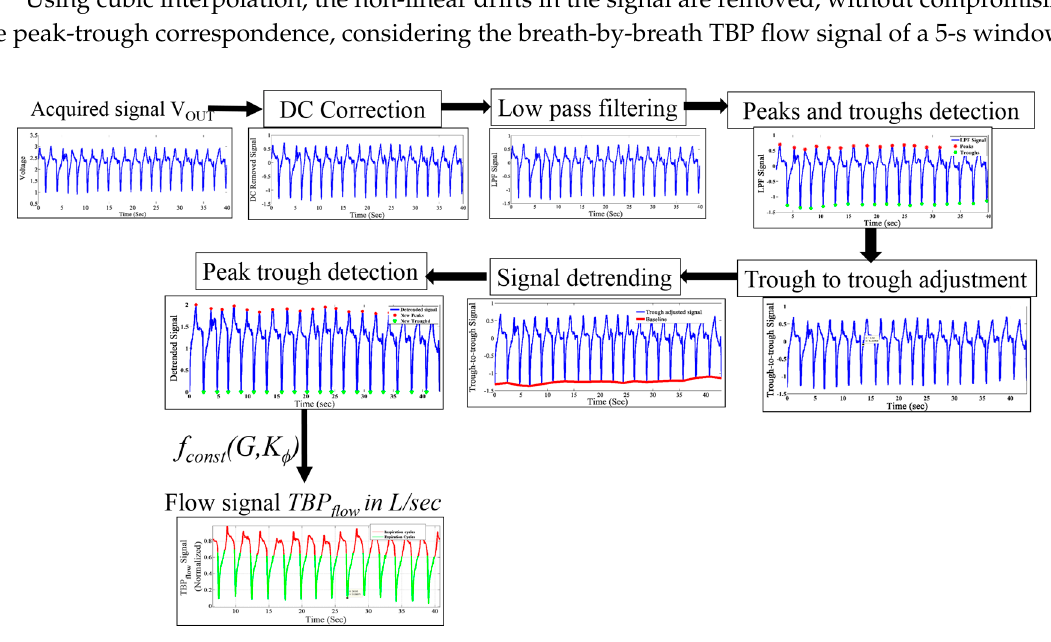
Figure 7. The TBP signal preprocessing steps.